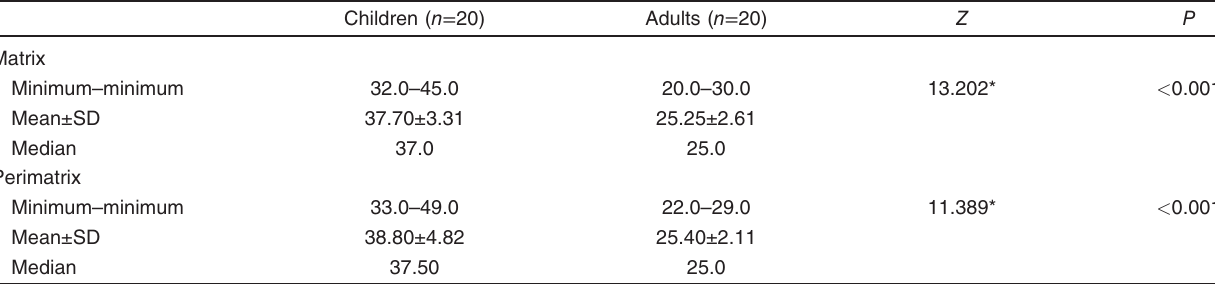
Table 1 Comparison between epidermal growth factor expression levels in children and adult cases of cholesteatoma